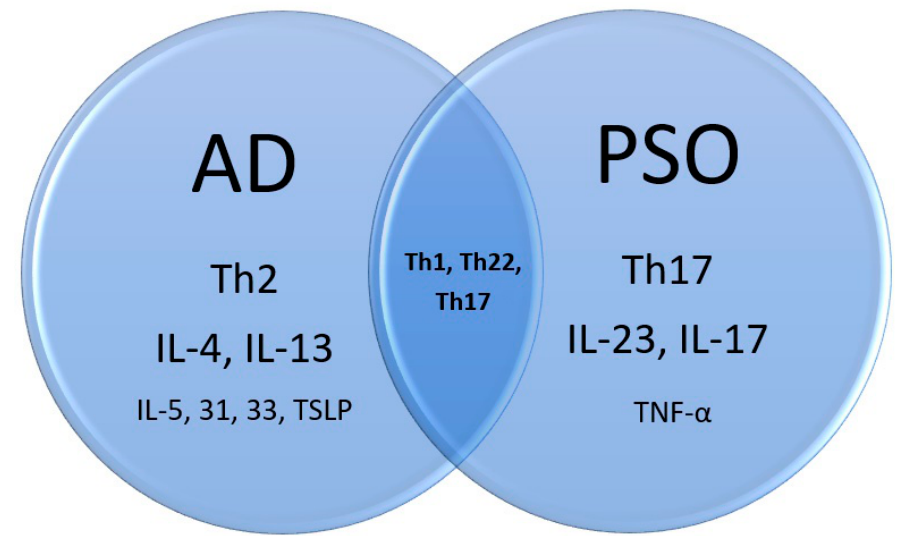
Figure 2. Immunopathogenesis of atopic dermatitis, psoriasis, and the overlap.